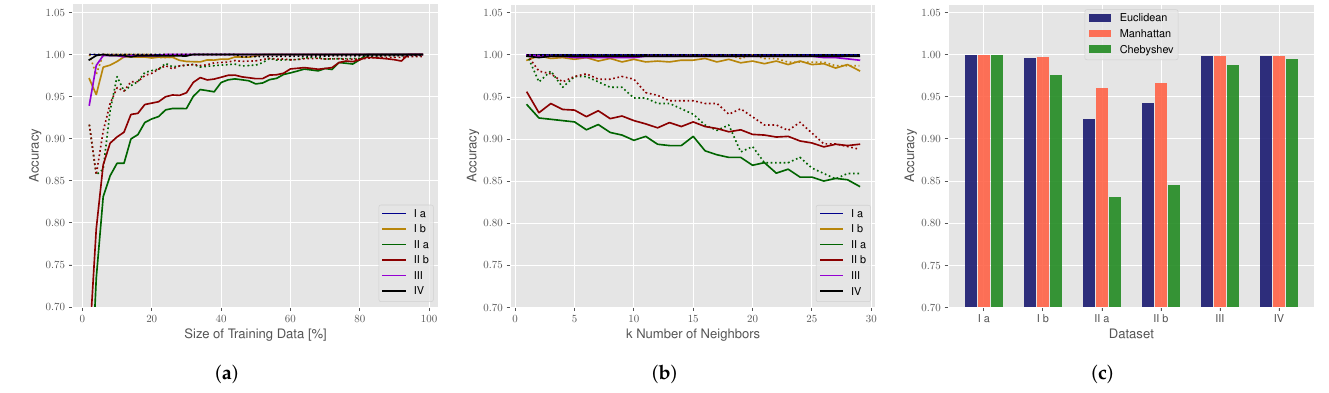
Figure 15. Influence of different parameters on the accuracy of the kNN classification: ( a ) size of the training dataset relative to overall dataset size; ( b ) number k of neighbors; ( c ) distance metrics. Accuracy of the testing data (solid line) and accuracy of the training data (dotted